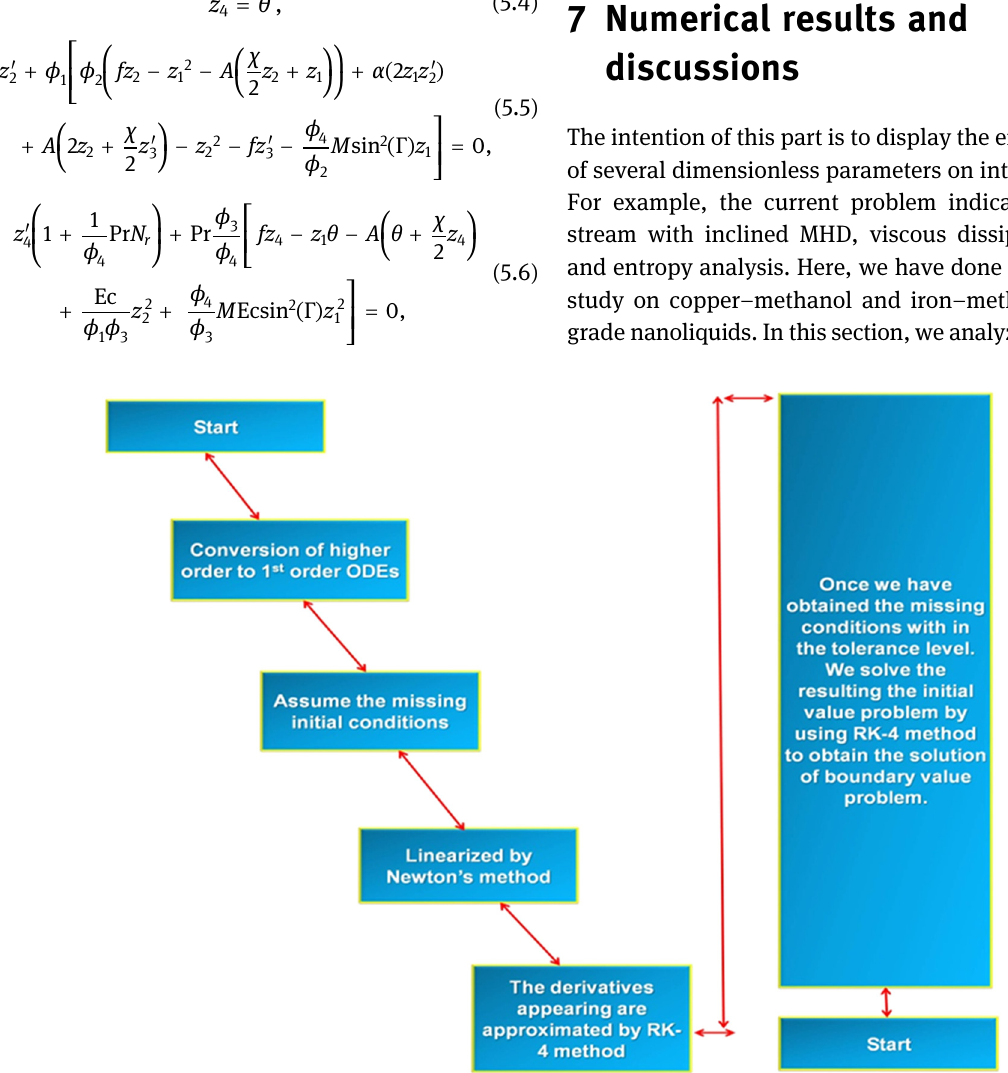
Figure 2: Shooting technique